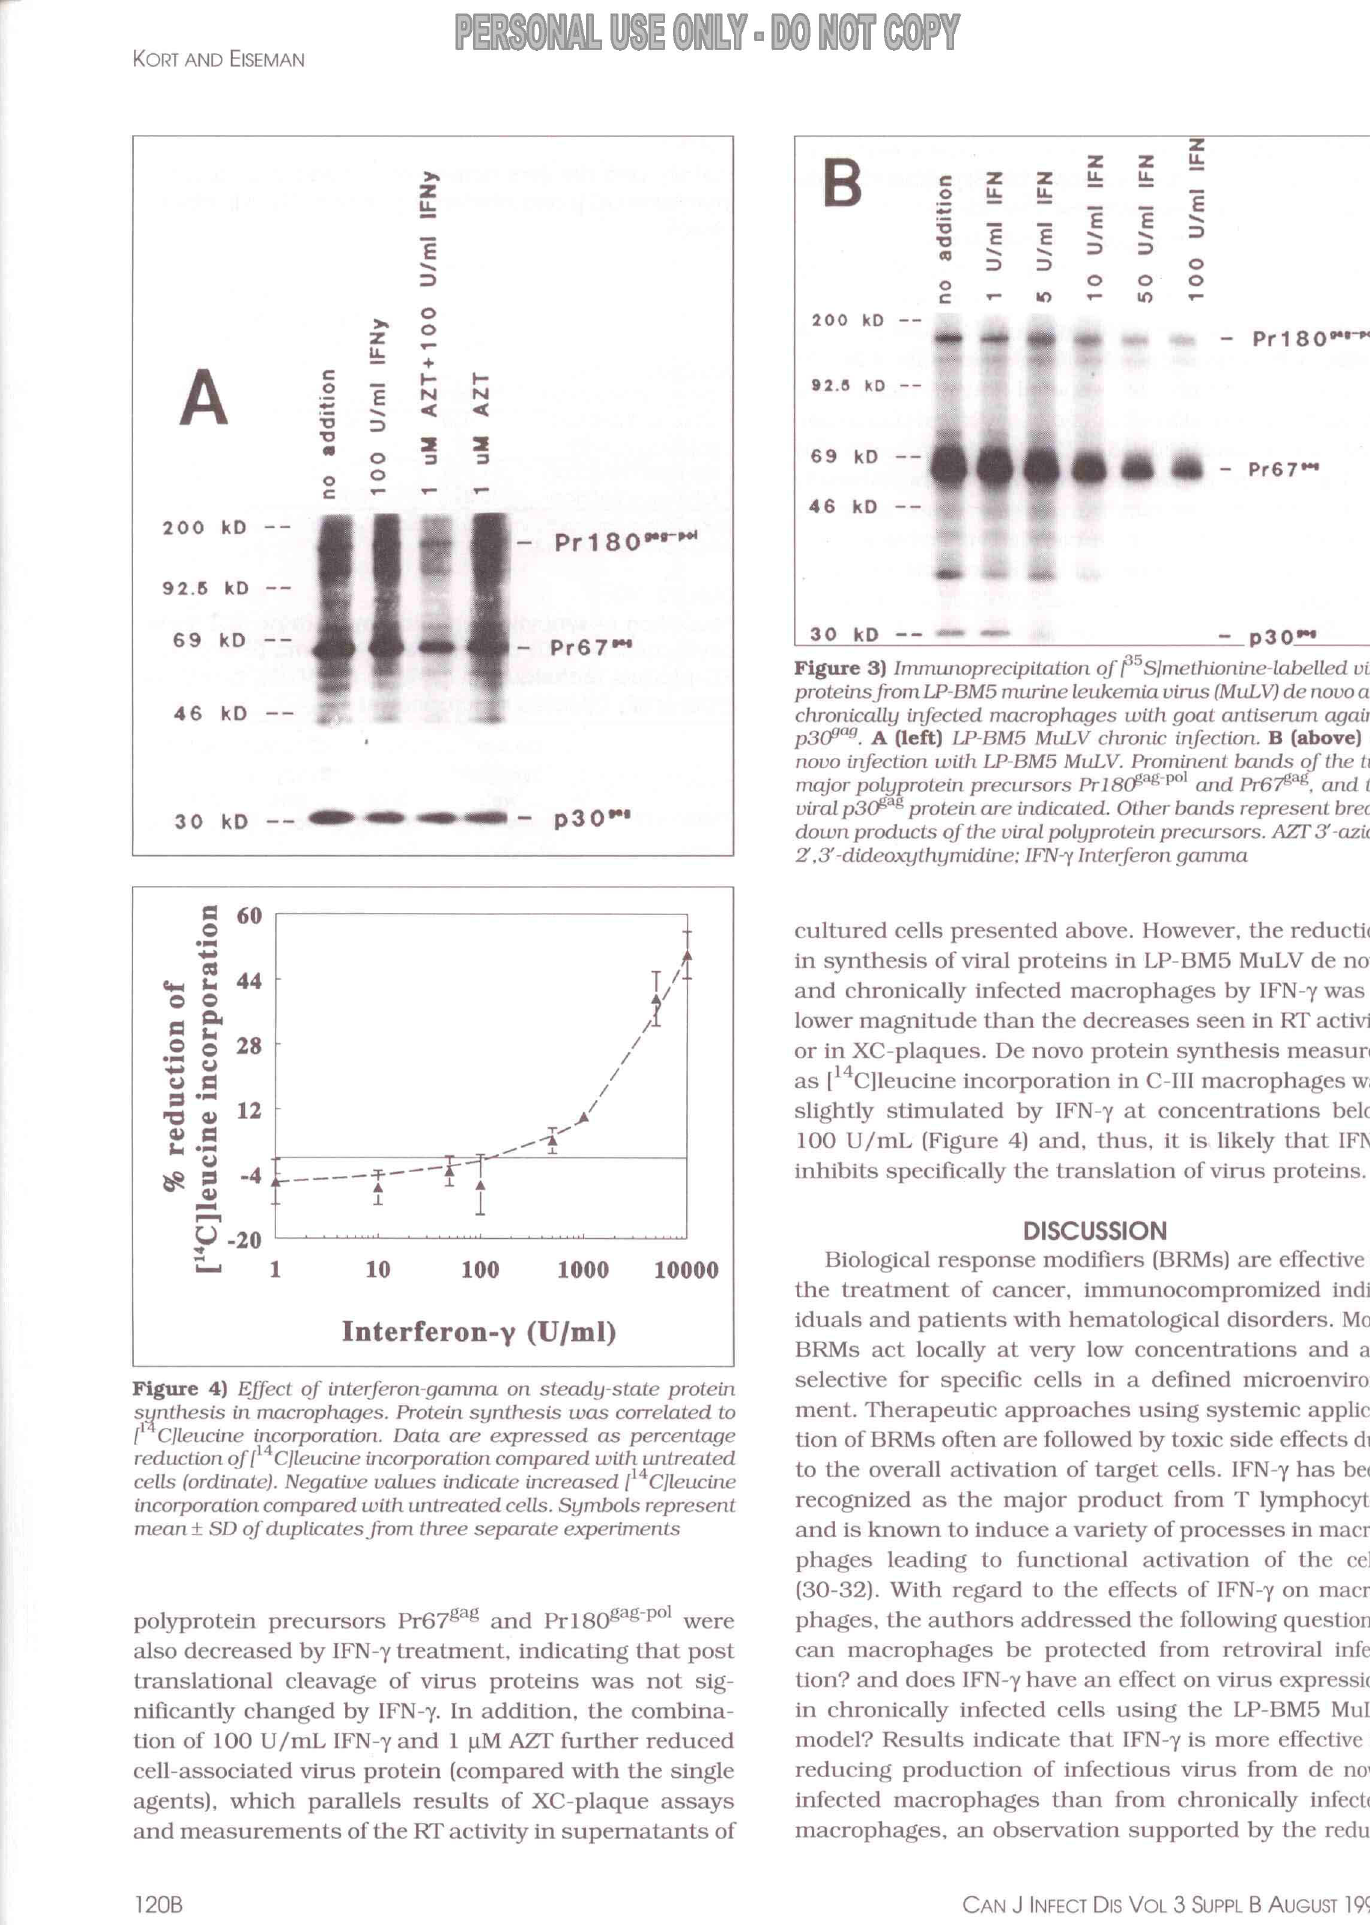
polyprotein precursors Pr67gag and Prl80gag-pol were